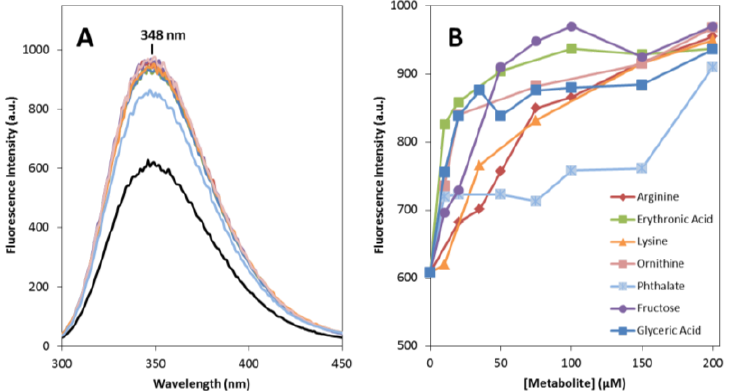
Figure 1. Metabolites impact on apoSOD1 tertiary structure. ( A ) Tryptophan fluorescence emission spectra of 5 μM apoSOD1 (black curve) and upon incubation with 200 μM of each metabolite (colors); ( B ) Concentration dependence of apoSOD1 tryptophan fluorescence emission maximum at 348 nm, for the different metabolites. See experimental section for further